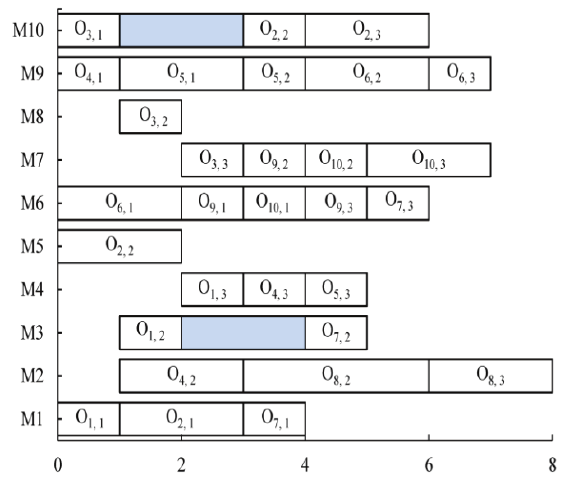
1 = 12, f 2 = 12, f 3 =60).